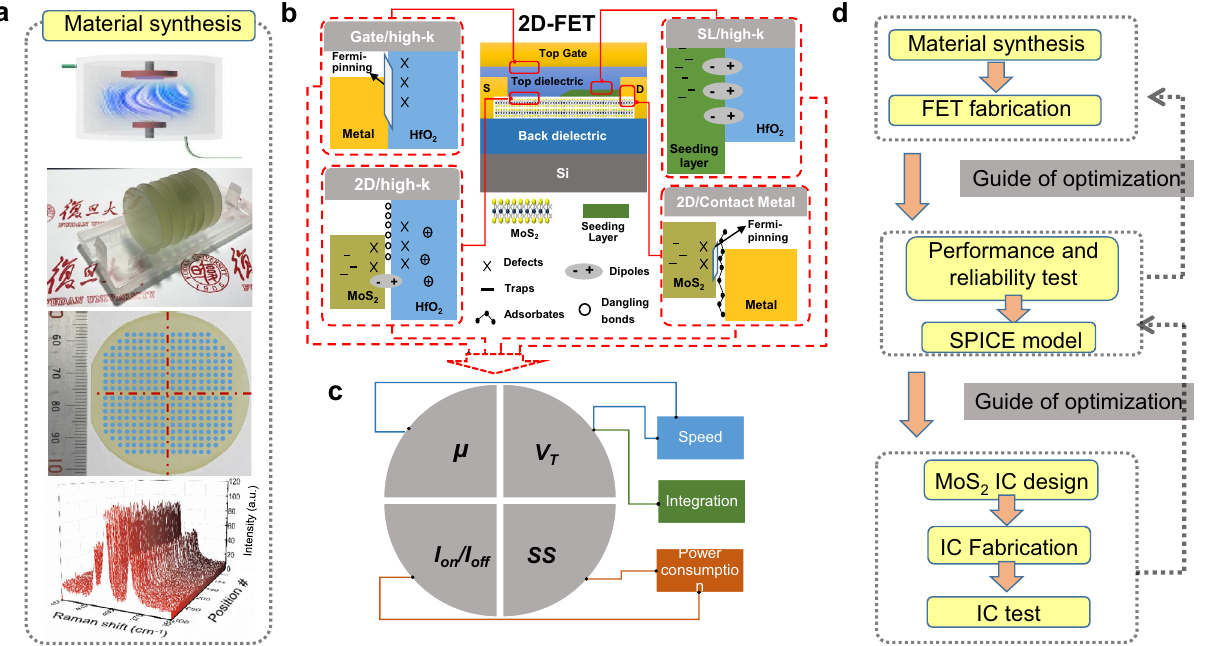
Fig. 1 A comprehensive picture of building MoS 2 2D-FETs. a Demonstration of uniform wafer-scale MoS 2 growth by CVD, including a schematic diagram of the material-growth equipment, a batch of 2-in. wafer-scale sapphire substrates uniformly covered with MoS 2 , a 2-in. sapphire wafer uniformly covered with MoS 2 marked with Raman test points, and Raman mapping spectra from different locations marked in the previous picture. b Schematic cross section of an MoS 2 FET with TG (top gate) and global BG (bottom gate). Various interface factors that in fl uence the device performance are categorized, including the insertion of seeding layer (SL) between MoS 2 and high-k dielectric (in this work, SL is deposited on the entire channel region), the interface between the TG and high-k dielectric, and the interface between MoS 2 and contact metals. c Schematic diagram of the relationship between performance parameters of the transistor and performance limitations of the integrated circuit, where µ , V T , I on / I off , and SS represent the mobility, threshold voltage, current on/off ratio, and subthreshold swing. d Process fl ow and feedback-optimization diagram from material synthesis to industrial-grade circuit design, fabrication, and From transistors to circuits . Since the FETs built on the wafer have high uniformity, we use an RPI model (level = 62) to simulate MoS 2 FETs in an HSPICE simulator. As is shown in Fig. 3a, b, to fi t the transfer and output characteristics of MoS 2 FETs, the parameters of the model are con fi gured by adjusting the empirical parameters and characteristic parameters (such as mobility and V T extracted from transfer curves, thickness and permittivity of the dielectric, and W and L of MoS 2 channel). The voltage-transfer characteristics (VTC) for a pseudo-NMOS MoS 2 inverter (M1 as a load transistor and M2 as a pull-down network) were also simulated in HSPICE using the simulation parameters from the same model. By sizing the aspect ratio W / L of two MoS 2 FETs (Fig. 3c) and shifting the V T value (Fig. 3d) of the M1 independently, the voltage-switching point can be tuned to the proper position (around half of V DD ) to achieve rail-to-rail output swing and large noise margin (Supplementary Note 11).